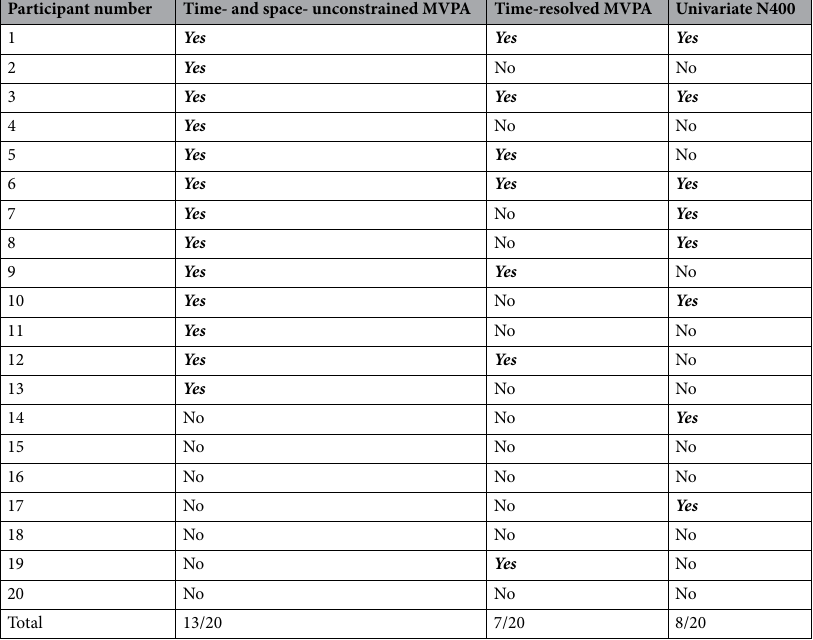
Table 2. Summary of individuals’ effect in different analyses. ‘Yes’ indicates that we found a significant effect for this